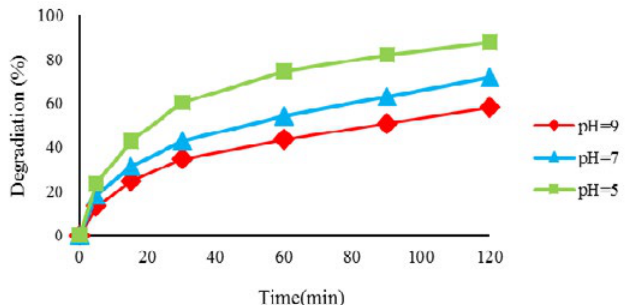
Fig. 3. Effects of pH on photocatalytic degradation of Fig. 3 Effects of pH on photocatalytic degradation of Clindamycin